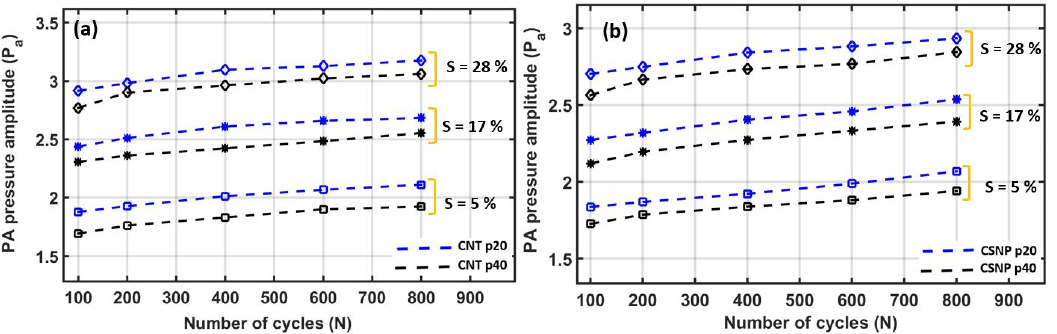
Figure 8. DET results for carbon-nanocomposite transmitters. ( a ) CNT-based nanocomposite trans- mitters, ( b ) CSNP-based nanocomposite transmitters ( S : strain).